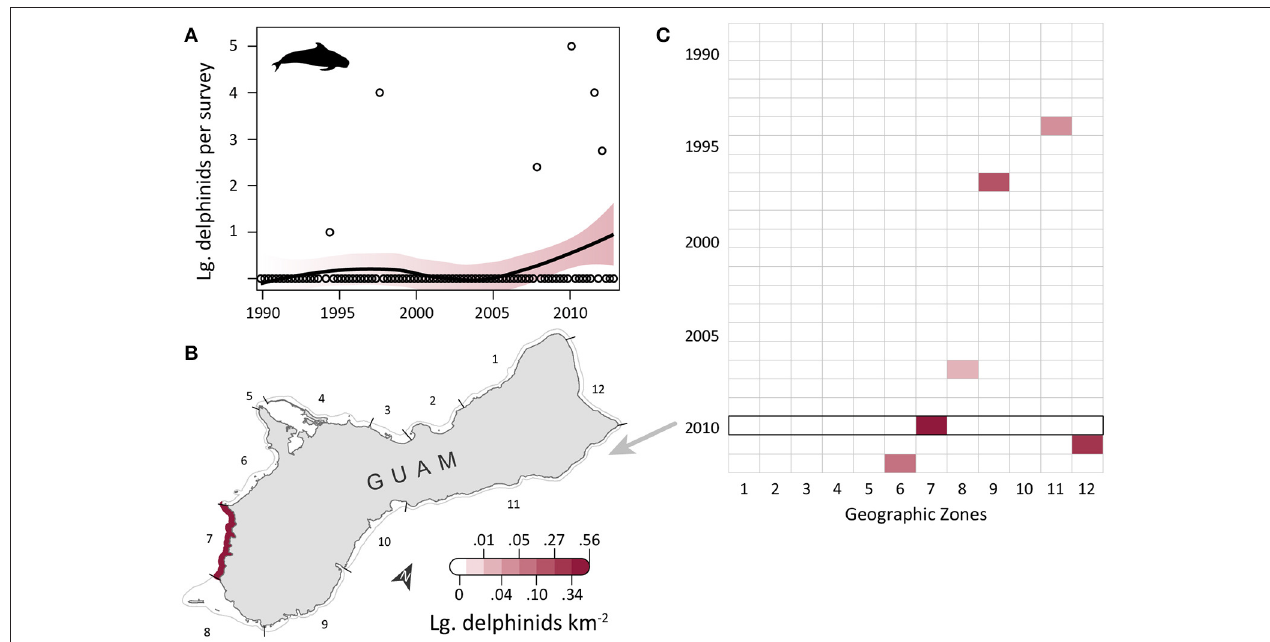
FIGURE 5 | Rare, possibly increasing observations of large delphinids in coastal waters of Guam since 1989. (A) Trend in large delphinid observations from aerial surveys conducted semimonthly by Guam Division of Aquatic and Wildlife Resources (DAWR). Open circles indicate quarterly observations (individuals) per survey (OPS). Smoothed line and shading are from a model fit with 95% confidence interval. Observations were rare, with no large delphinids recorded in 75% of survey years. (B) Map of observed densities for 2010, the year with the highest OPS. Density was positive in the southwest (zone 7), but zero elsewhere. (C) No large delphinids were observed in zones 1–5 along the west coast or in zone 10 on the east coast. Large delphinids were recorded in a maximum of one zone per year (zones 6–9 and 11–12). Sightings appear to be more frequent since